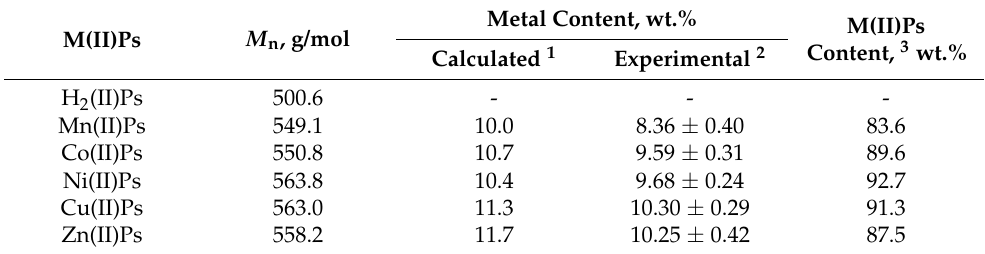
Table 4. Composition of petroporphyrin products synthesized in the present